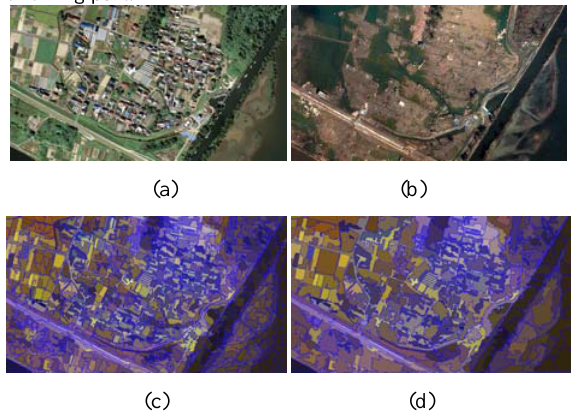
Figure.5 Instances of Multi-scale Segmentation, (a)Fujitsuka in Sendai before Disaster,(b)Fujitsuka in Sendai after Disaster, (c)Integrated Segmentation Result on Scale 20 (d)Integrated Segmentation Result on Scale 40